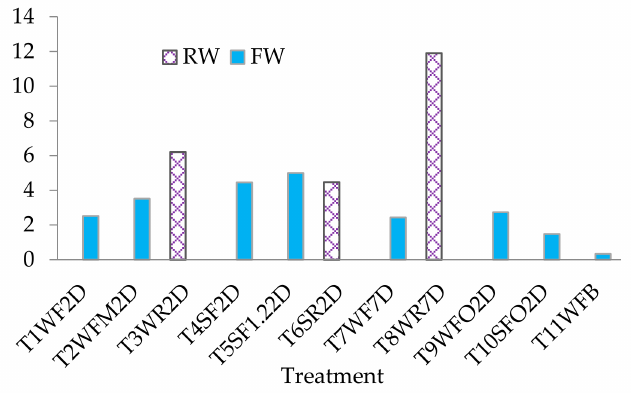
Figure 4. Percentage of unmarketable fruits within each irrigation treatment. RW = recycled water, FW = fresh water. See Table 2 for treatment